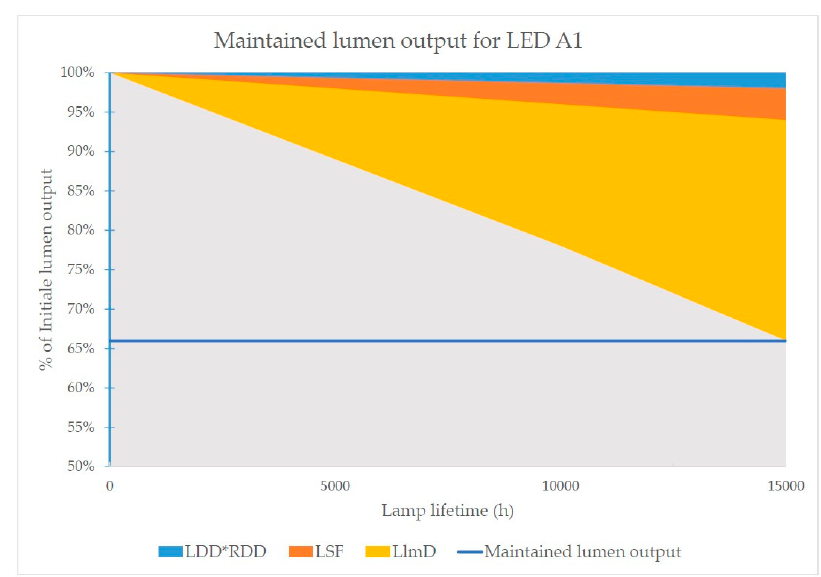
Figure 4. Maintained lumen output for LED A1.